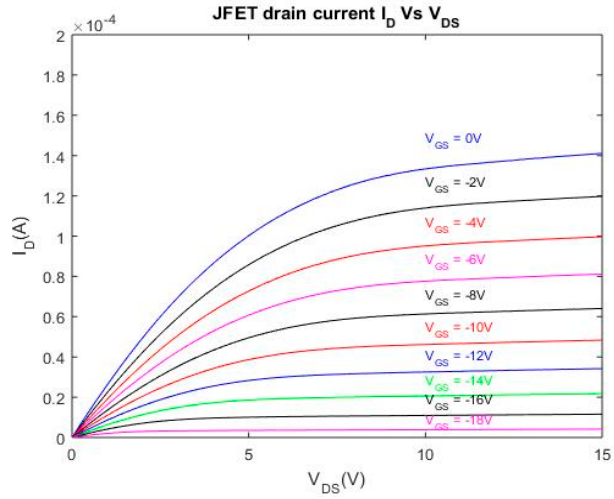
Figure 3. Drain characteristics of JFET fabricated in the Institute of Microelectronics (IME) process.